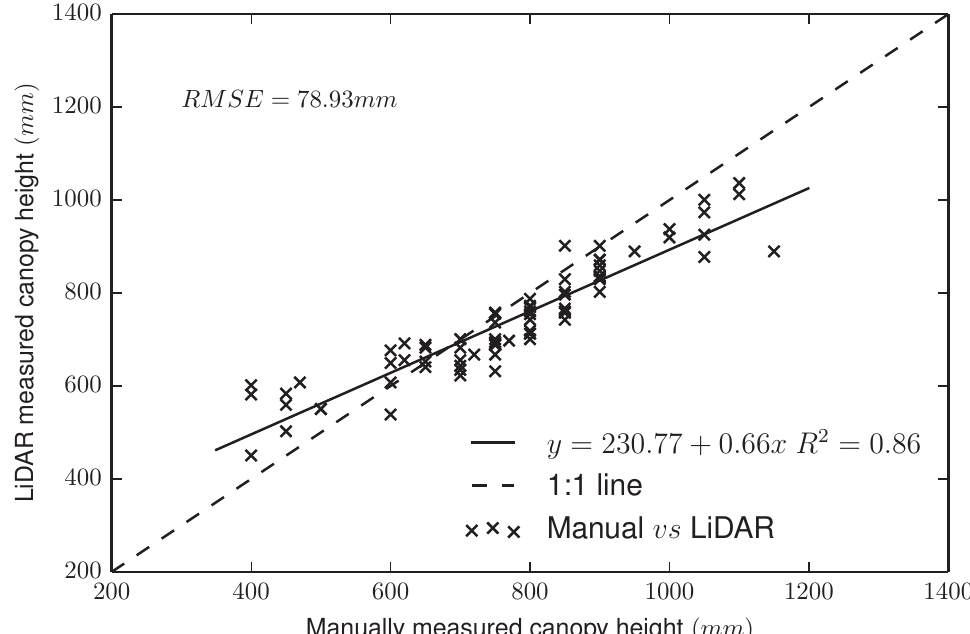
Figure 5. Comparison of canopy height measured manually on wheat using the traditional ruler method and the height estimated with the LiDAR. The resulting relationship shows R 2 = 86 and RMSE = 78 . 93